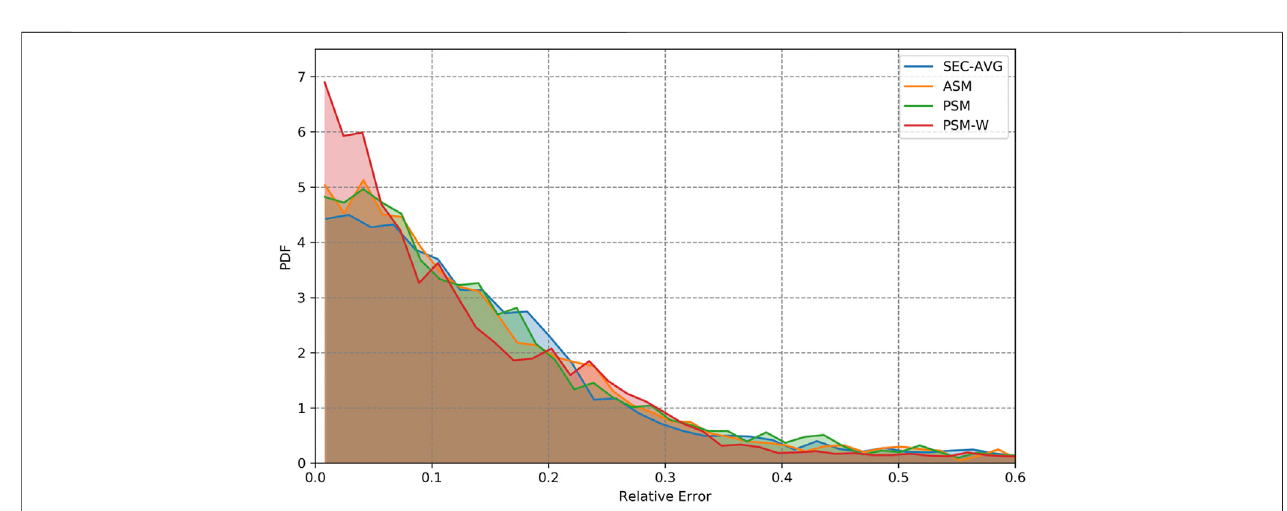
FIGURE8| Approximatedprobabilitydensityfunctionofrelativeerrorscomparingthetraveltimesofvirtualtrajectoriesbasedoneachalgorithmwiththemeasured travel times collected via BT